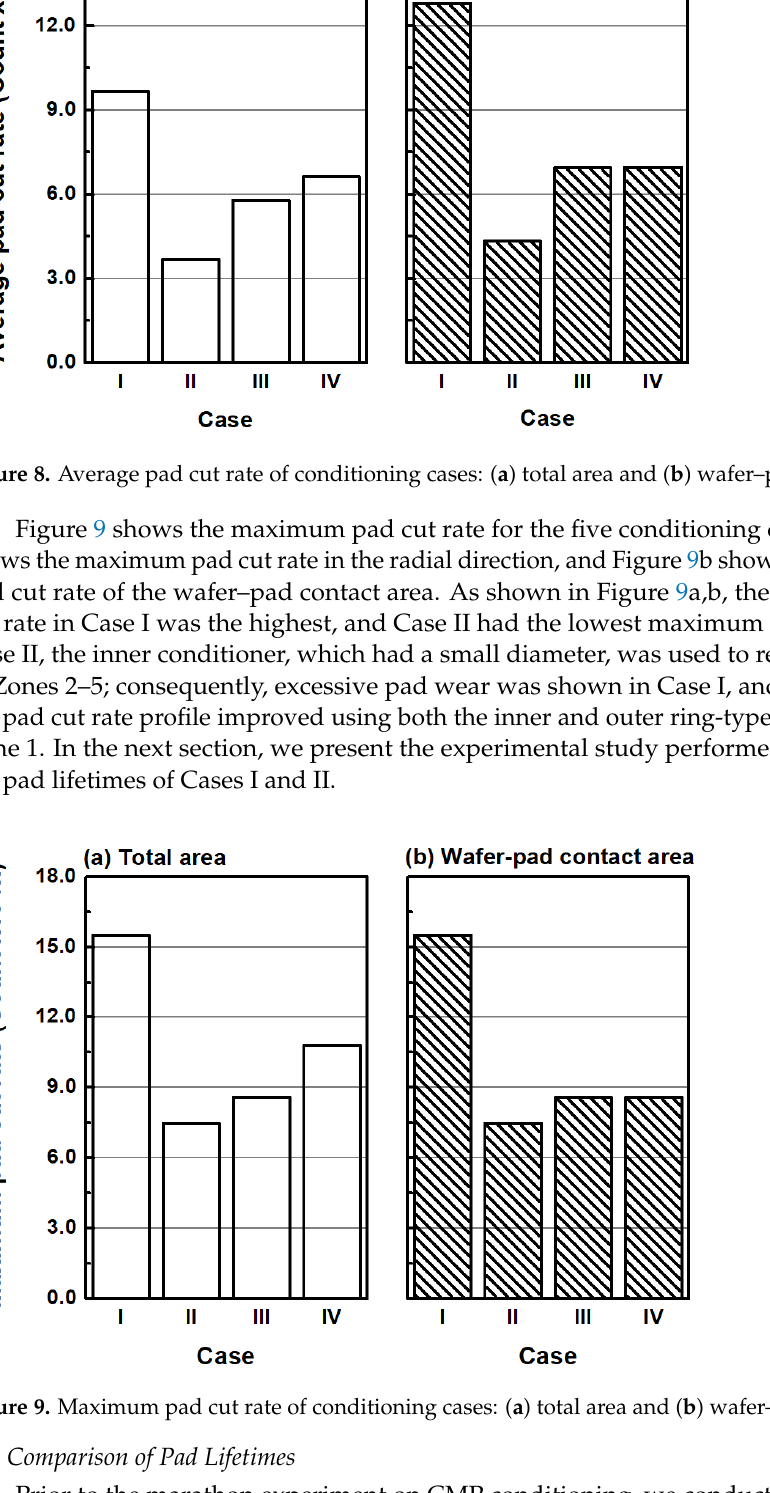
Figure 9. Maximum pad cut rate of conditioning cases: ( a ) total area and ( b ) wafer–pad contact